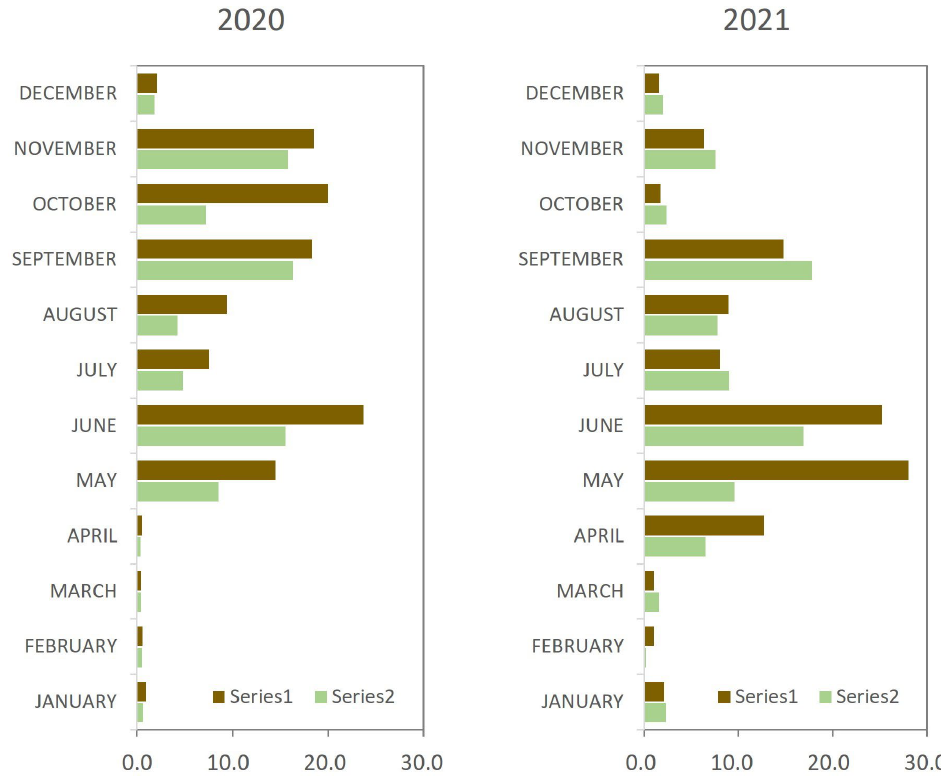
Figure 2. Spore release month by month in the control and in the aspiration plots in 2020 and 2021.